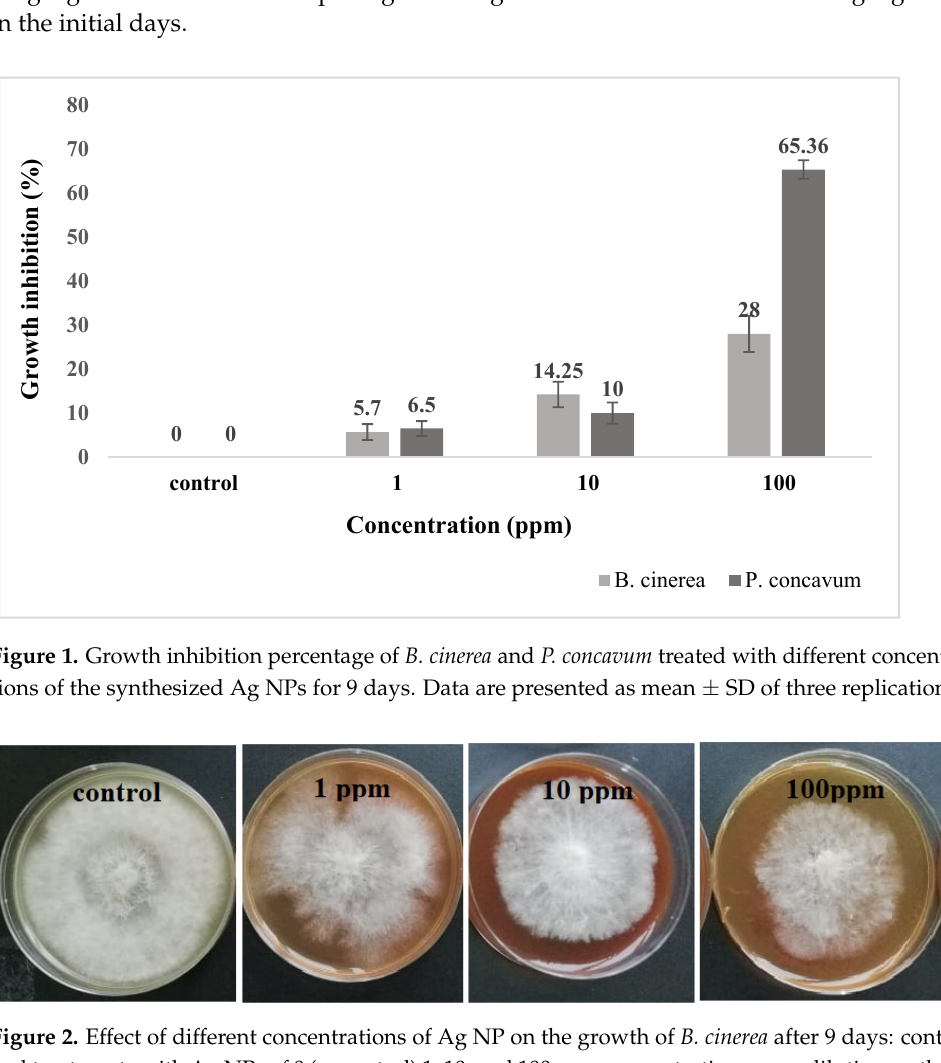
Molecules 2021 , 26 , x